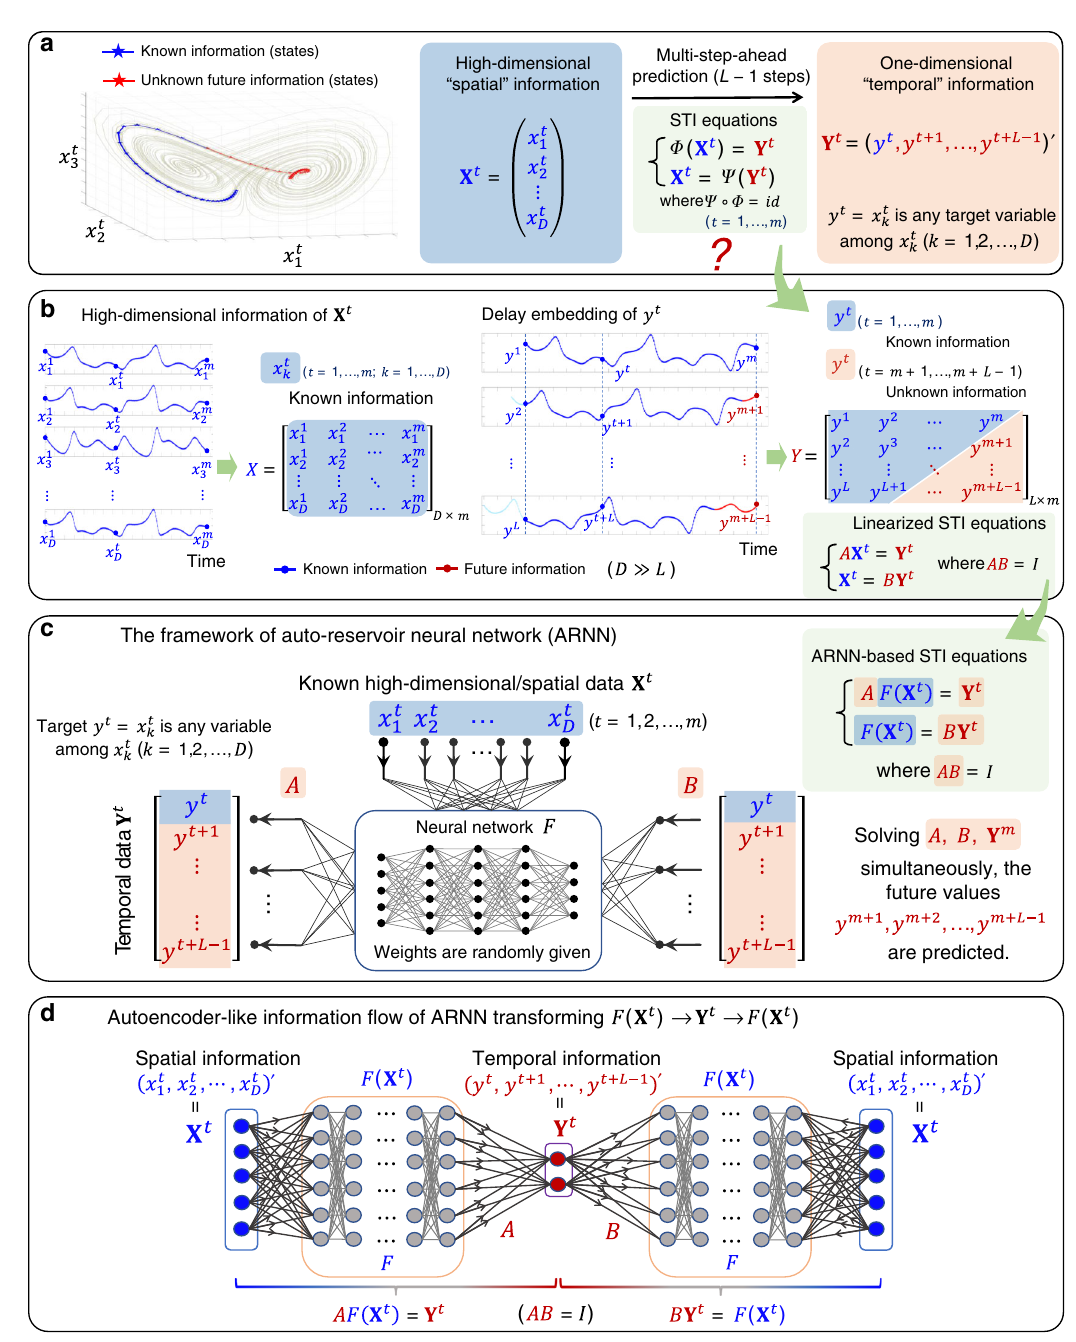
Fig. 1 Schematic illustration of the auto-reservoir neural network. a Given a short-term time series of a high-dimensional system, it is a challenging task to predict future states of any target variable. For a target variable y to be predicted, a delay-embedding strategy is applied, forming a delayed-coordinate vector Y t corresponding to the observed vector X t via a function Φ . Such a relation constitutes the spatiotemporal information (STI) transformation with both primary and conjugate forms (STI equations). b The linearized STI equations also have primary and conjugate forms. Data can be represented in a matrix form where the future/unknown information { y m þ 1 ; y m þ 2 ; ¼ ; y m þ L (cid:2) 1 } is located in the lower-right triangle of matrix Y and the known information { y 1 , y 2 , … , y m } in the upper-left part of Y . c Auto-reservoir neural network (ARNN) is a model-free method to make the multistep-ahead prediction for a target y . In the ARNN framework, the reservoir component contains a random/ fi xed multilayer neural network F , for which there are time-dependent inputs X t . A target vector Y t formed by the delay embedding for the prediction is processed through neural network F with two weight matrices A and B . Such an architecture of ARNN is designed to simultaneously solve both primary and conjugate forms of ARNN-based STI equations to enhance the robustness, thus predicting the future information of the target variable y even with a short-term time series. d According to the information fl ow, ARNN has an autoencoder-like framework, that is, F ð X t Þ ! Y t ! F ð X t Þ , different from but similar to the autoencoder structure X t ! Y t ! X t